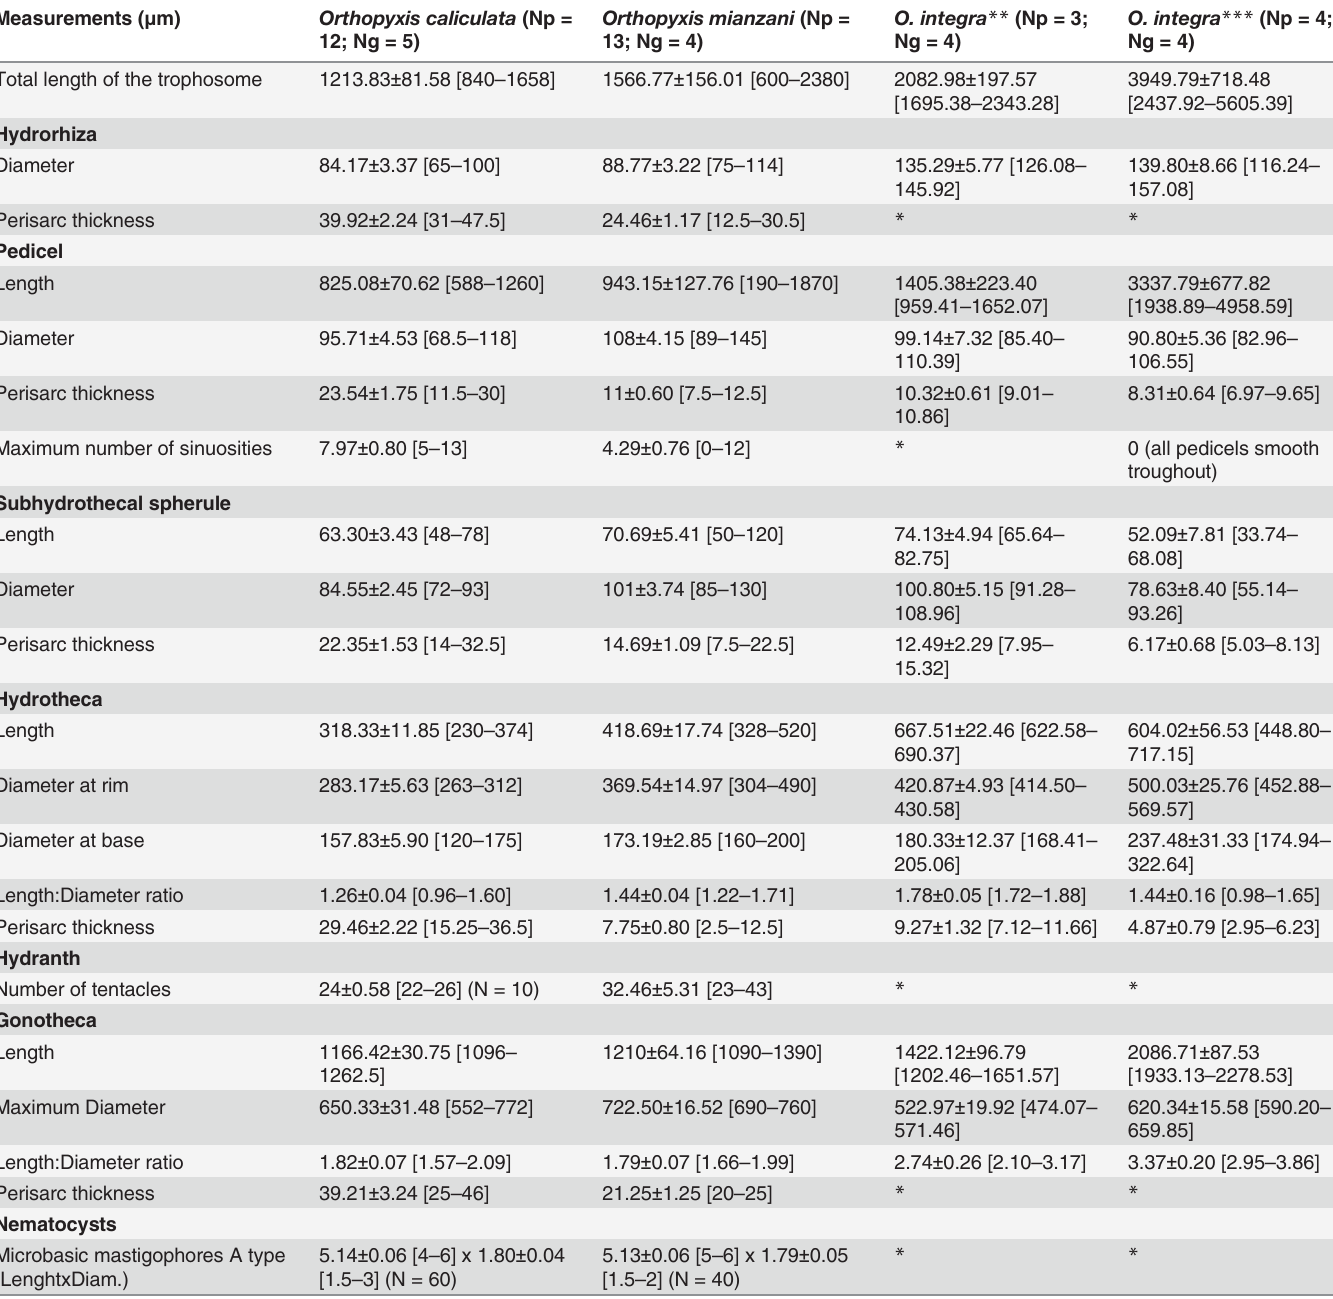
Table 6. Comparative measurements of Orthopyxis caliculata , Orthopyxis mianzani (mean ± standard error [range]) and specimens of Orthopyxis integra from the National Museum of Natural History, Smithsonian